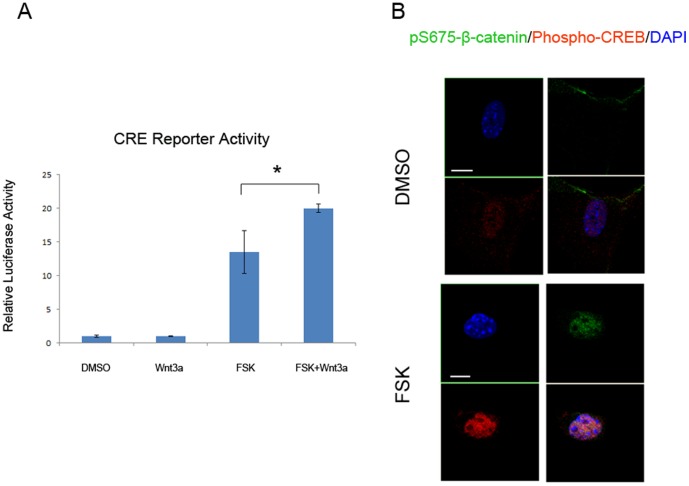
CREB and β-catenin cooperation promotes cAMP-dependent transcription.A. MC3T3-E1 cells were transfected with a cAMP responsive element luciferase construct. Luciferase assay was performed following stimulation of vehicle, FSK, or Wnt3a (100 ng/ml) as indicated (* P<0.05). Error bars represent standard deviation. B. IF co-localization of pS675β-catenin (green) and pS133-CREB (red) in response to FSK stimulation. DAPI (blue) stains the nucleus. The bottom right panel of each group shows the merged image. Scale bar: 10 µm.